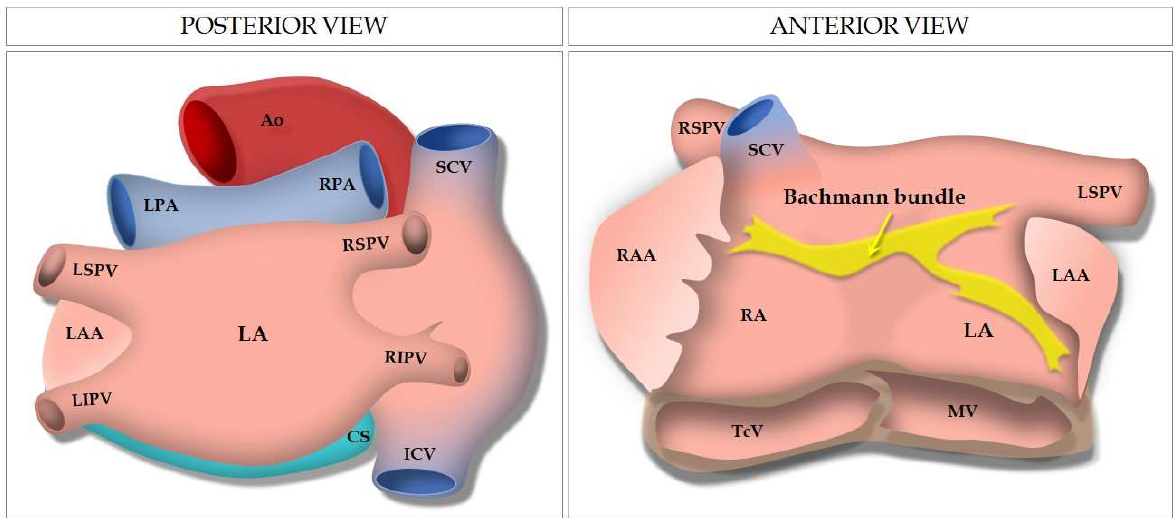
Figure 1. Illustration showing the anterior and posterior view of the LA and the anatomical relationships with adjacent structures. Ao: aorta; CS: coronary sinus; ICV: inferior cava vein; LA: left atrium; LAA: left atrial appendage; LIPV: left inferior pulmonary vein; LPA: left pulmonary artery; LSPV: left superior pulmonary vein; MV: mitral valve; RA: right atrium; RAA: right atrial appendage; RIPV: right inferior pulmonary vein; RPA: right pulmonary artery; RSPV: right superior pulmonary vein; SCV: superior cava vein; TcV: tricuspid valve.